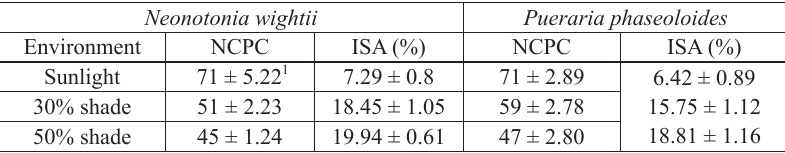
Number of chlorophyllic parenchyma cells (NCPC) and percent area occupied by intercellular spaces (ISA) in Neonotonia wightii and Pueraria phaseoloides leaves cultivated under different light intensities 1 ± standard error of the